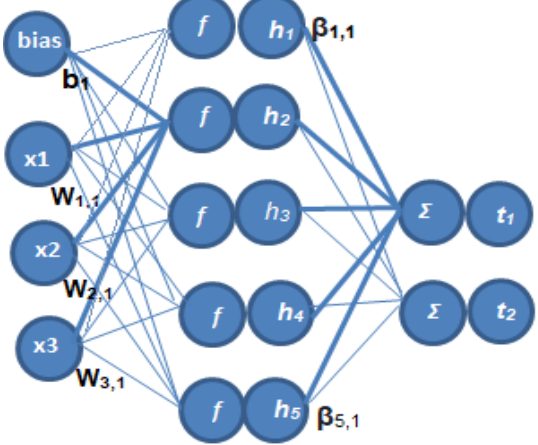
Figure 5. Single Hidden Layer Feed ‐ Forward Neural Networks .